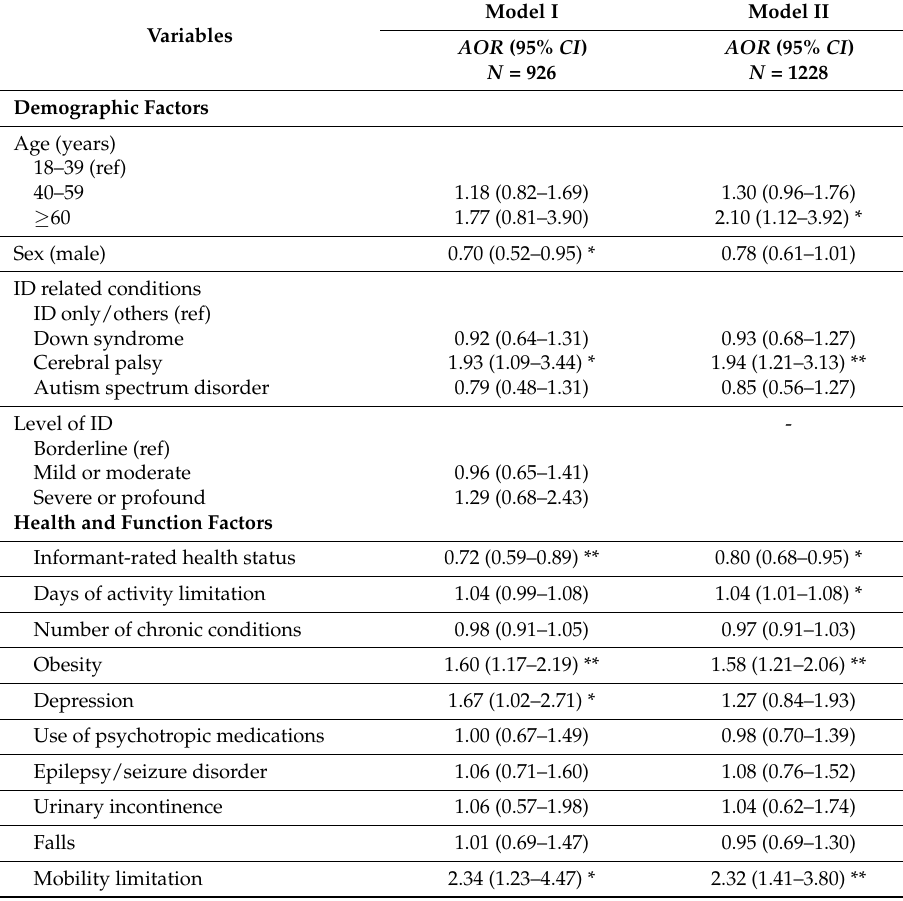
Table 3. Summary of multiple logistic regressions for